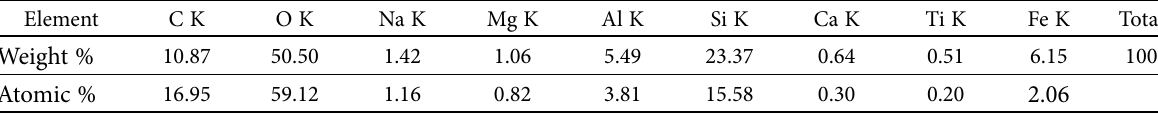
Table 3. Composition of FS after used in photo-Fenton process Element